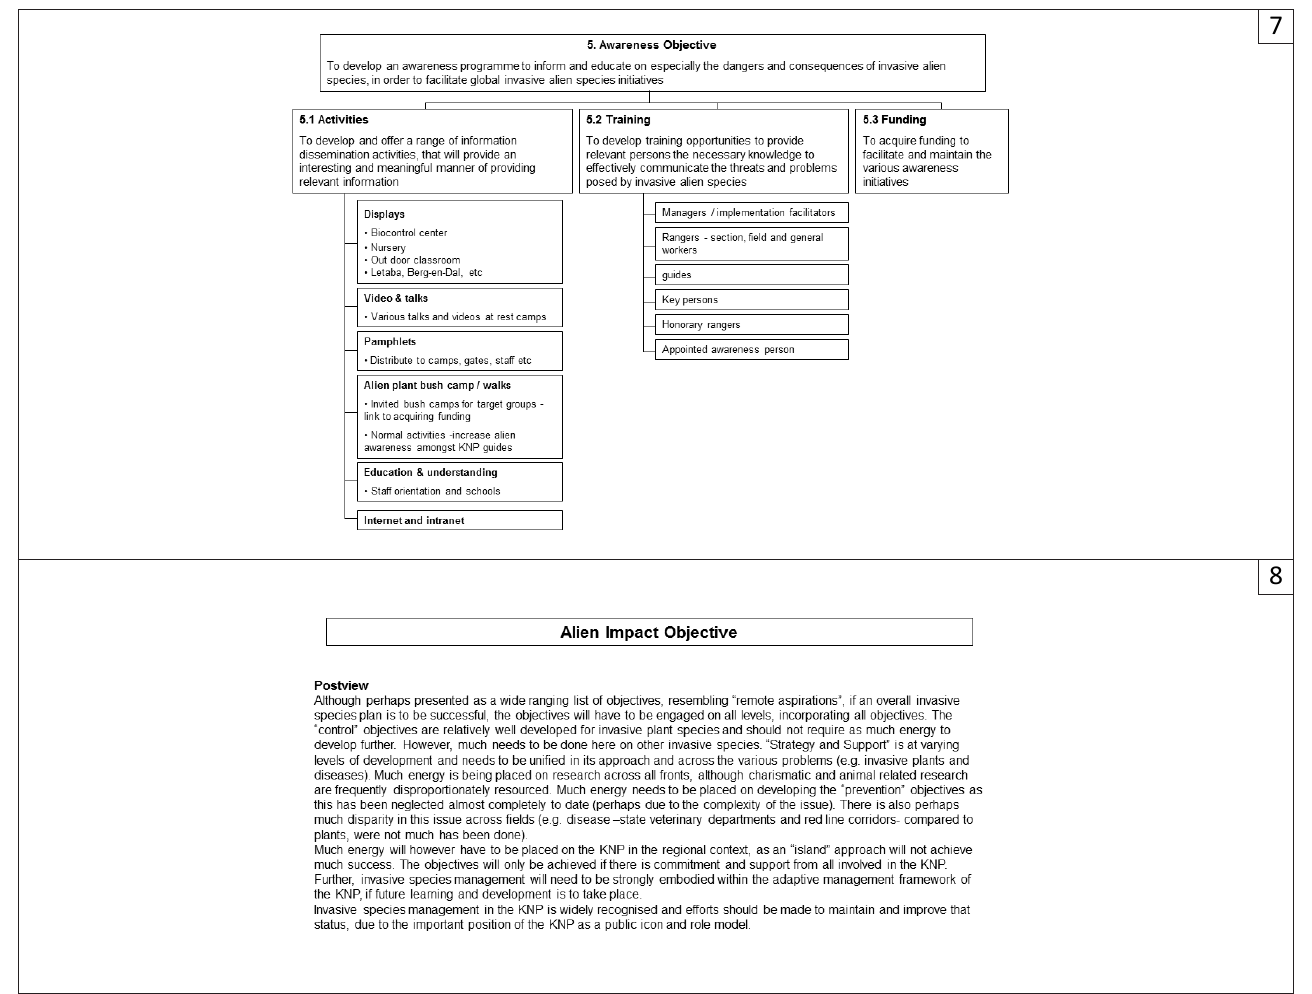
FIGURE 1 (Continues...): An expanded overview of the proposed framework to implementing the control of invasive alien species. The framework indicates the key components, with the salient points, and their linkages. The numbers cross link to the discussion. We also differentiate between documents, activities and/or processes, actions, and bodies and/or